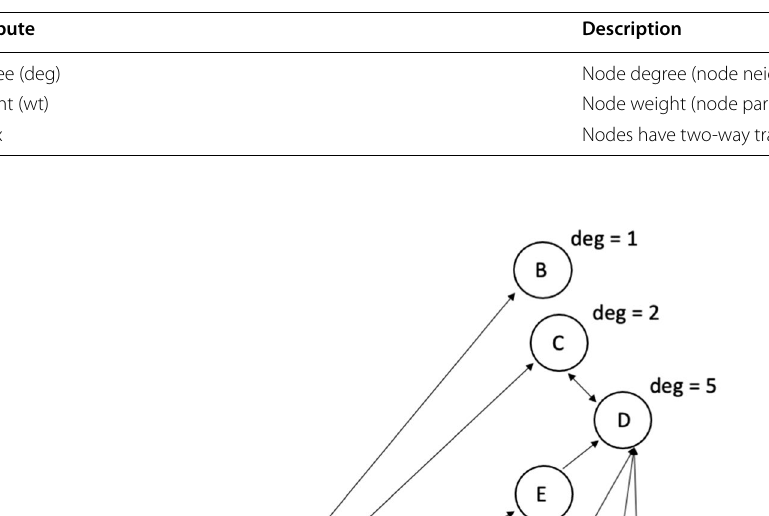
Table 3 Extended IEC 104 attributes